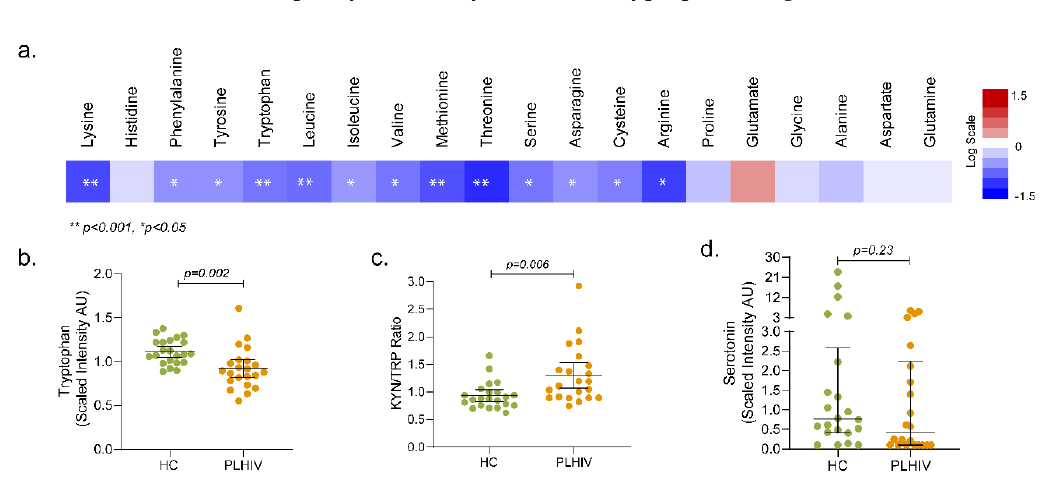
Figure 7. Metabolic pathways associated with HIV-1 infection following long-term therapy ( a ) Altered amino-acid metabolism. Amino acids ( n = 20) that were significantly lower (in blue) or higher (in red) in PLHIV compared to HC. The level of tryptophan ( b ), Kyn/Trp ratio ( c ), and serotonin ( d ).